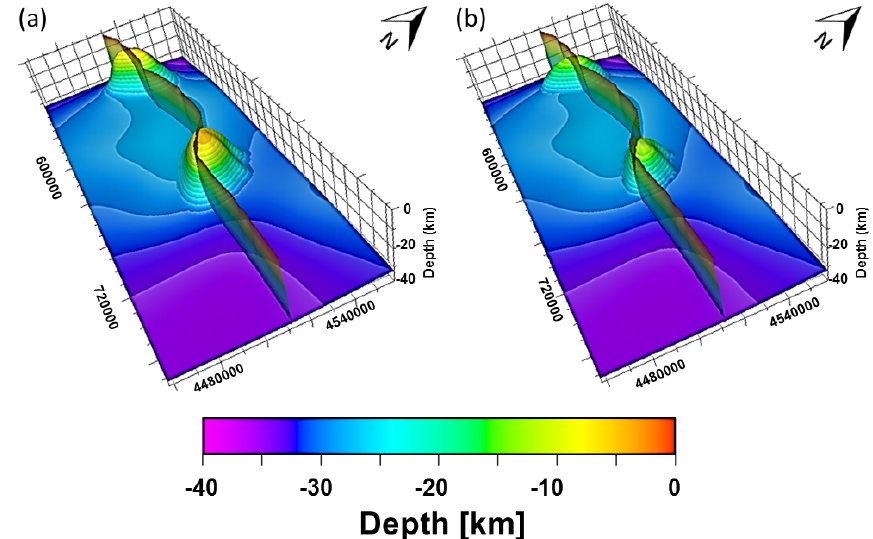
Figure 11. 3-D view of the Moho, the high-density bodies, and the MMF plane across the model area (WGS84, UTM zone 35 ◦ N). The high-density bodies’ location spatially correlates with the bent segments of the MMF. (a) High-density bodies according to Model I and Model III with an average density of 3150 and 2890kgm − 3 , respectively; (b) high-density bodies according to Model II with an average density of 3150kgm − 3 . The Moho depth and the 3-D fault plane from Hergert and Heidbach (2010). Table 1. Structural units resolved in three alternative density models (Model I, Model II, and Model III) of the Sea of Marmara with interpreted lithology and corresponding physical properties. The seismic velocity and density relationship is based on Eq. (1) (Brocher, 2005). Note that the high-density bodies have not yet been imaged by seismic observations, and their physical properties are according to the density